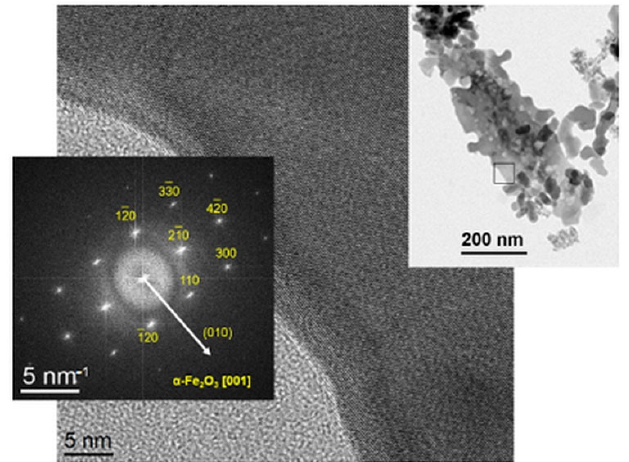
Figure 5. HRTEM micrograph of an elongated hydrohematite particle in sample Fe 2 O 3 _Na-500 and its fast Fourier transform. The position of the HRTEM micrograph is marked in the bright-field micrograph displayed in the top right panel. The arrow in the FFT indicates the normal direction to the lattice planes (010).